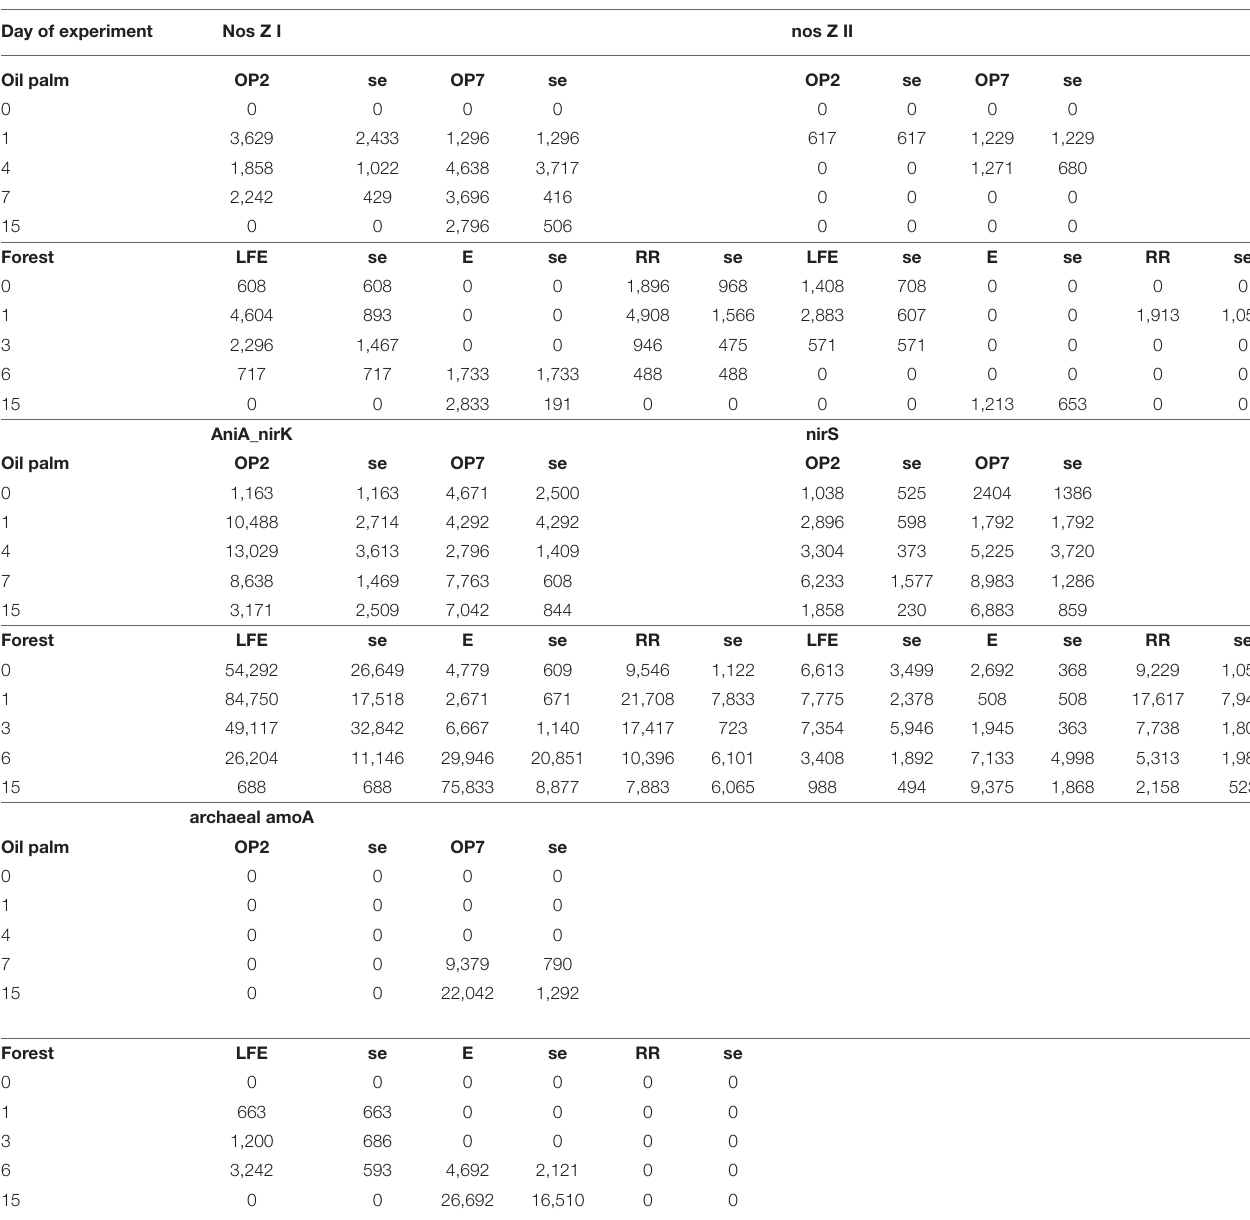
TABLE 2 | Mean gene transcript abundance from selected days of the incubation experiments with oil palm and forest soil from Sabah. Day of